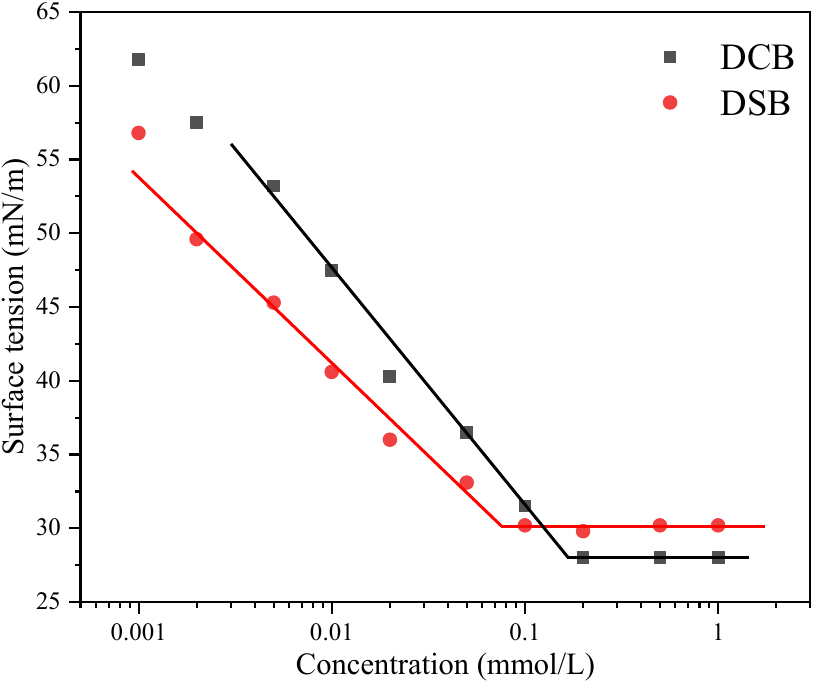
Figure 2. Variation of the surface tension with the surfactant concentration for DCB and DSB at 25 °C.